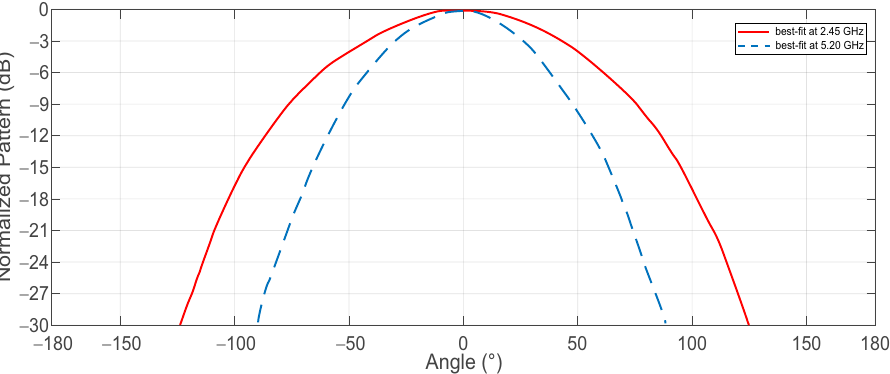
Figure 3. Radiation patterns of the SBA antennas implemented in the simulation